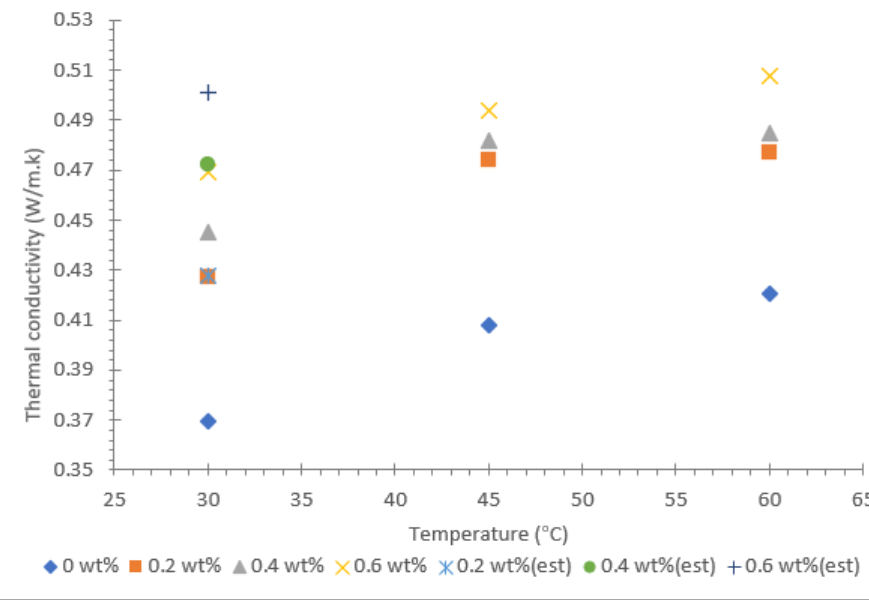
Figure 7. Thermal conductivity of coconut oil/Al 2 O 3 -TiO 2 hybrid nanofluid.